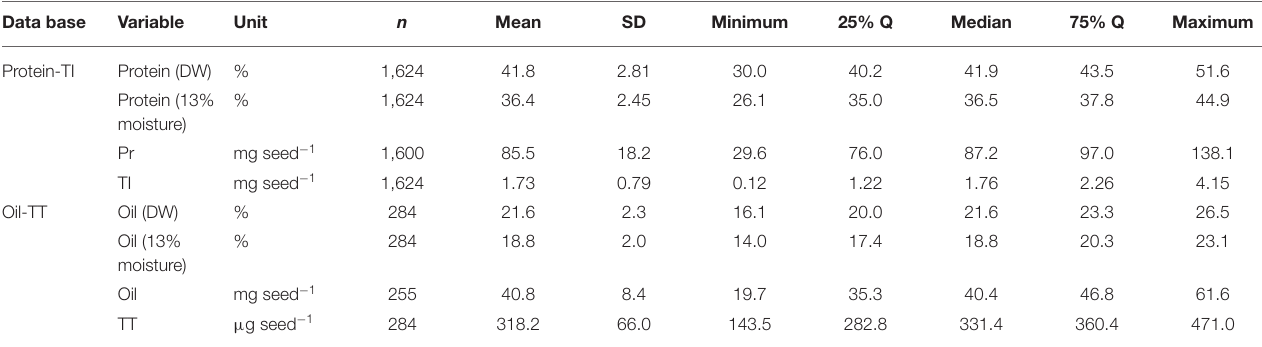
TABLE 3 | Descriptive statistics of the two meta-databases, one relative to soybean seed protein concentration [expressed as percentage of dry weight (DW) and adjusted to 13% moisture] and content (mg seed − 1 ), and total isoflavone (TI) content (mg seed − 1 ); the other relative to seed oil concentration (expressed as percentage of DW and adjusted to 13% moisture) and content (mg seed − 1 ), and total tocopherol (TT) content ( µ g seed − 1 ). Data